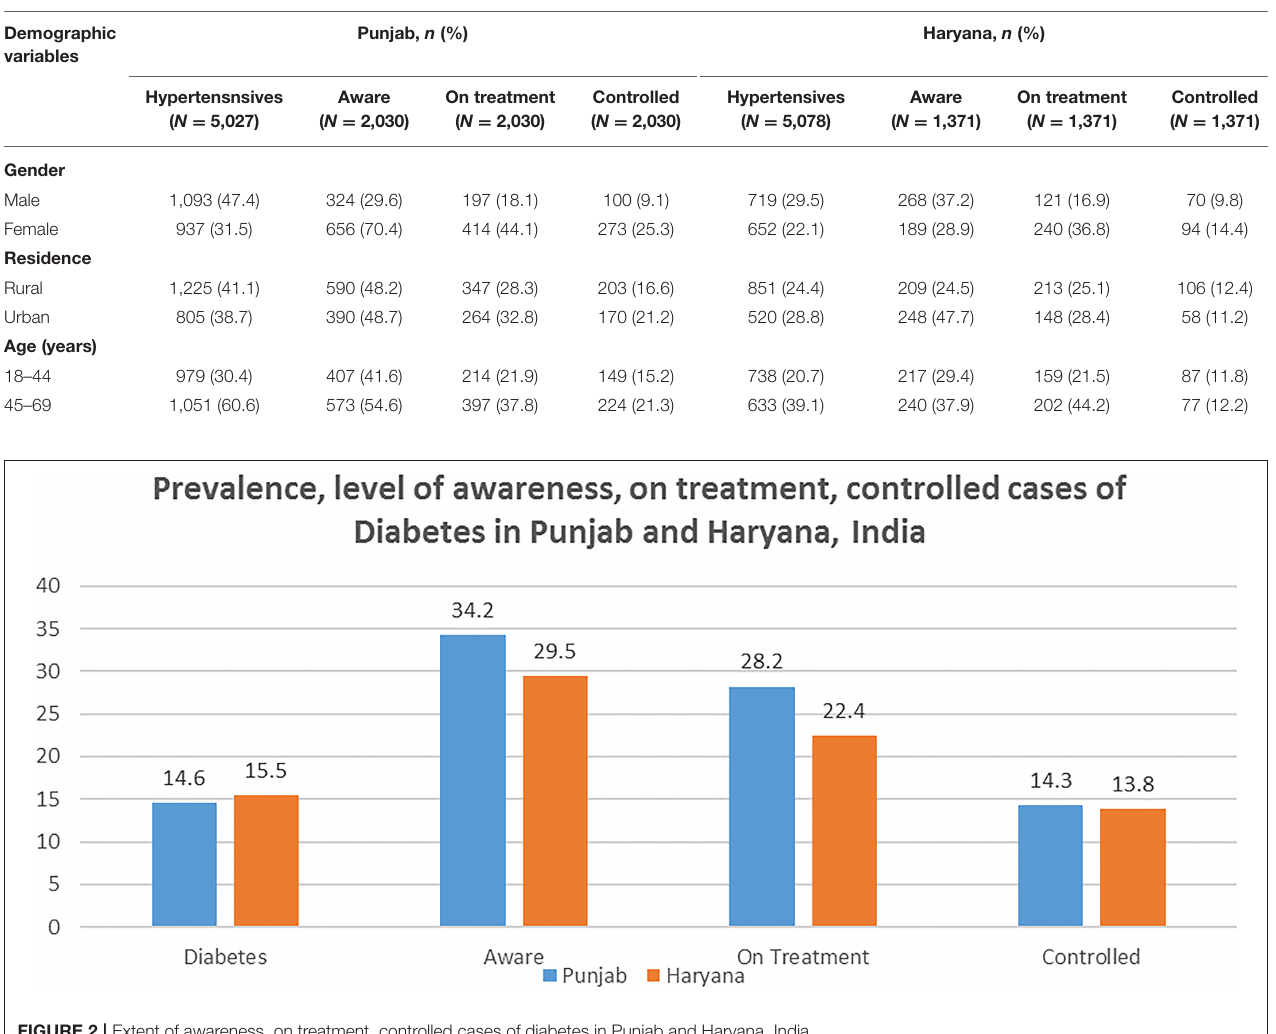
FIGURE 2 | Extent of awareness, on treatment, controlled cases of diabetes in Punjab and Haryana,